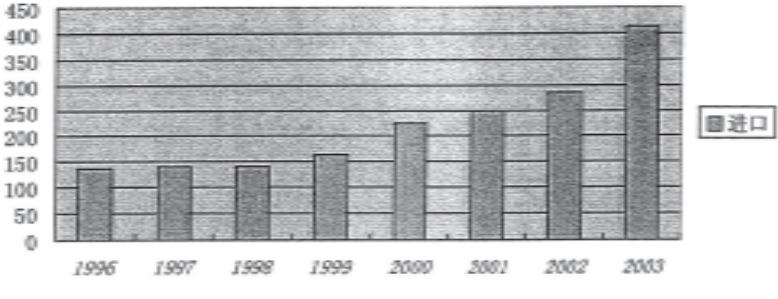
Figure 7. China’s import